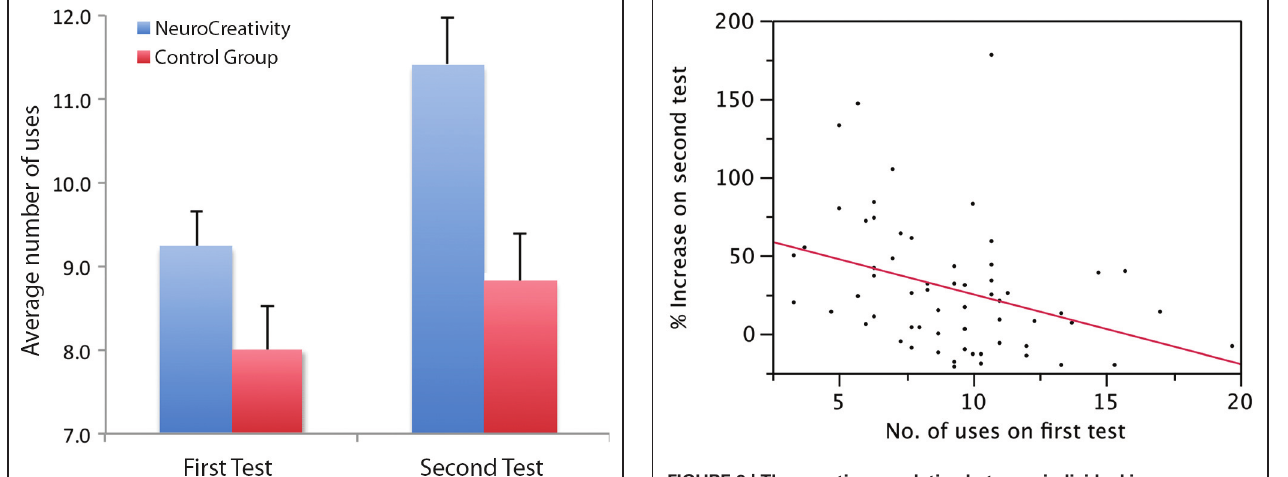
FIGURE 3 | The negative correlation between individual increase calculated in percentage on the second test and performance on the first test